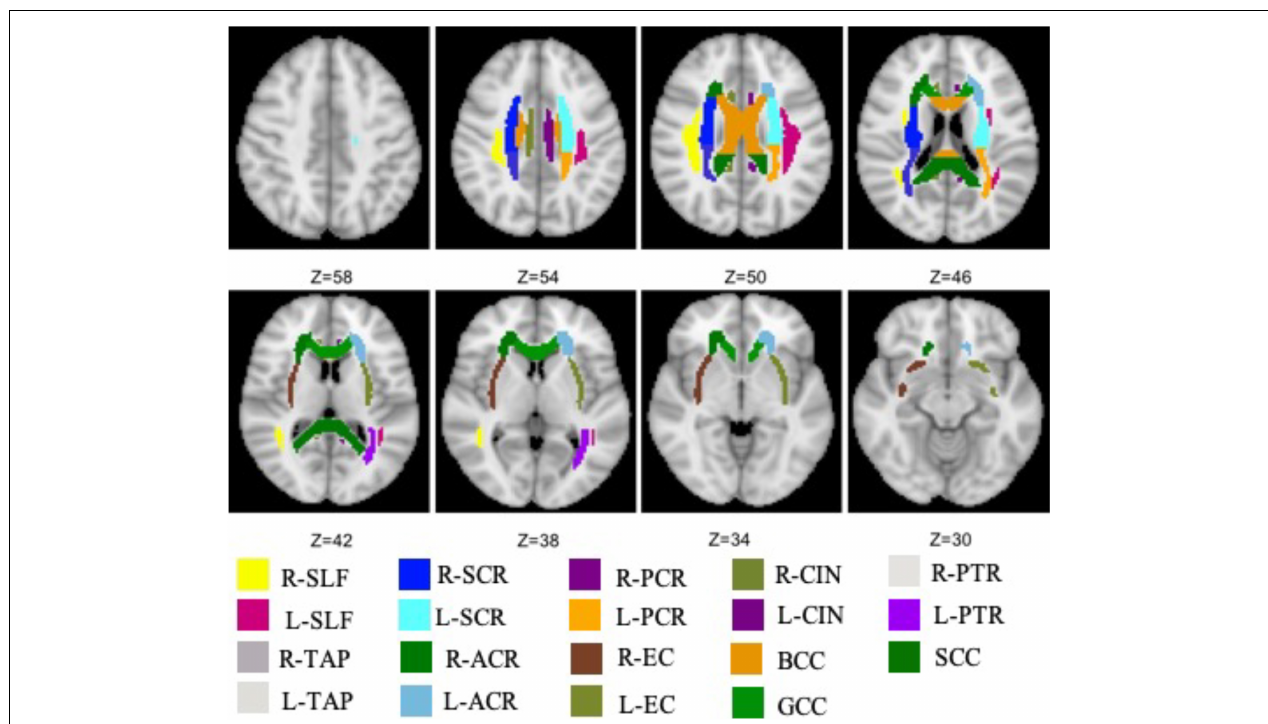
FIGURE 1 | All WM tracts, extracted from JHU white-matter atlas, are analyzed in this work. SCR, superior corona radiata; SLF, superior longitudinal fasciculus; ACR, anterior corona radiata; PCR, posterior corona radiata; BCC, body of the corpus callosum; CIN, cingulate; EC, external capsule; GCC, genu of the corpus callosum; PTR, posterior thalamic radiation; SCC, splenium of the corpus callosum; TAP, tapetum.